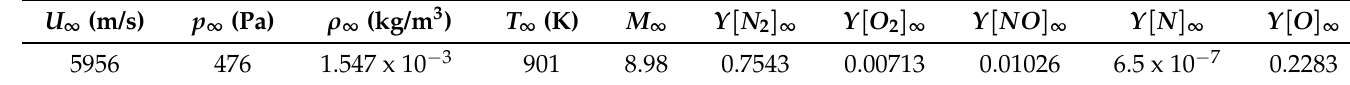
Table 4. HEG free-stream